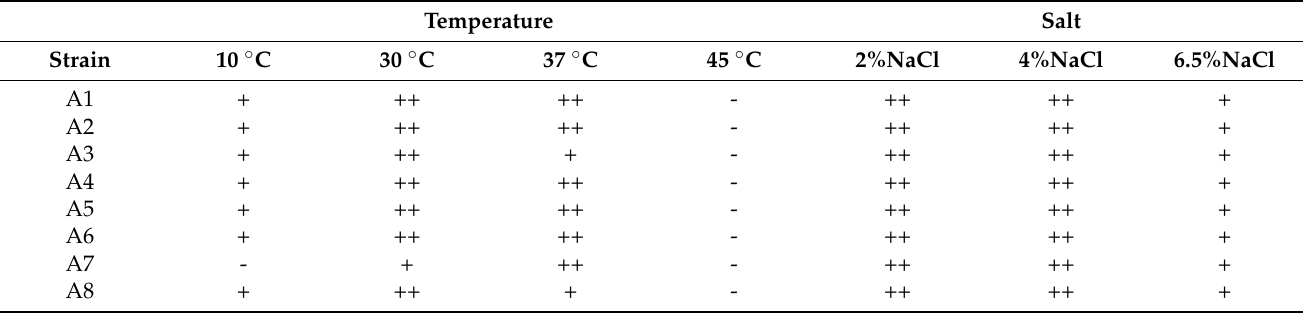
Table 1. Growth of 26 selected strains at various temperatures and salt concentrations after 48 h of